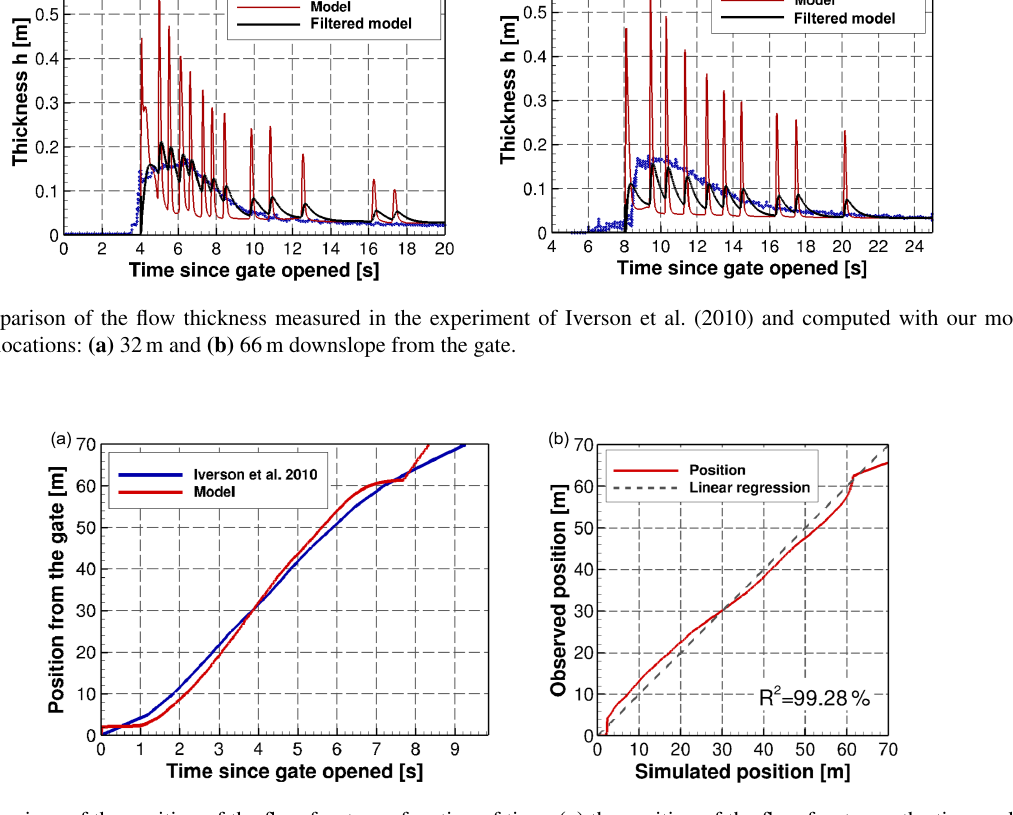
Figure B9. Comparison of the position of the flow front as a function of time: (a) the position of the flow front over the time and (b) com- parison of the experimental and simulated flow front position. The dashed line is the perfect fit with a slope equal to